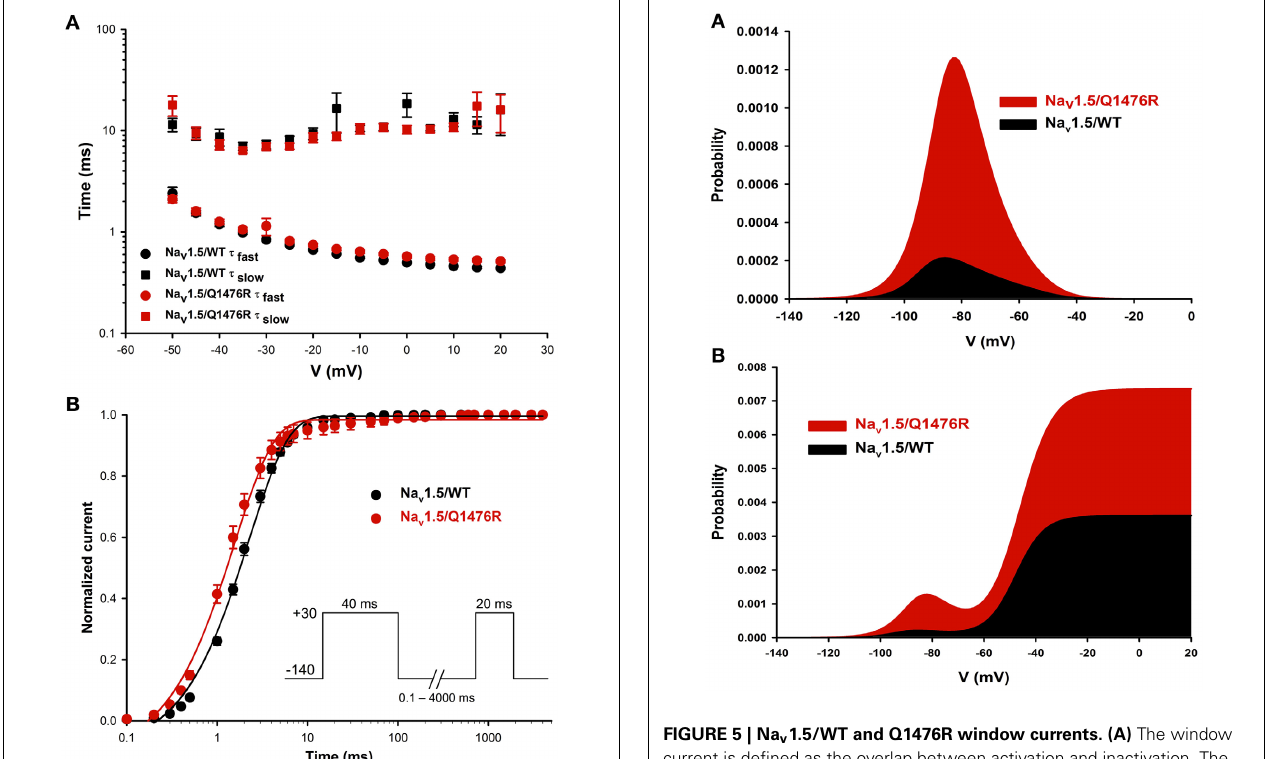
FIGURE 5 | Na v 1.5/WT and Q1476R window currents. (A) The window current is defined as the overlap between activation and inactivation. The window current was obtained using the following equation: (1/(1 + exp(( V 1 / 2activation − V )/ k activation )) × ((1 − C )/(1 + exp(( V − V 1 / 2inactivation )/ FIGURE 4 | Time constants of inactivation and of recovery from k inactivation )) + C ). (B) The INap component was added to the window inactivation. (A) Curves representing the time constant of inactivation as a current of the WT or the Q1476R function of the voltage for the WT and Q1476R channels. A two-exponential function was used to fit the inactivation curves observed on whole cell current traces: I = A fast ( exp [− ( t − k )/ τ fast ] ) + A slow ( exp [− ( t − k )/ τ slow ] + C ), where A fast and A slow are fractions of recovery of the fast and slow components, t is time, and k is the delay factor for activation or inactivation. τ − 50 to + 20mV for τ fast and slow were obtained from the equation from the Na v 1.5/WT and Q1476R channels. (B) Recovery from fast inactivation of the WT (black) and Q1476R (red) channels. Curves were obtained using the two-pulse protocol shown in the inset. The pulses ( + 30mV) induced maximal activation, and the time interval between pulses represents the